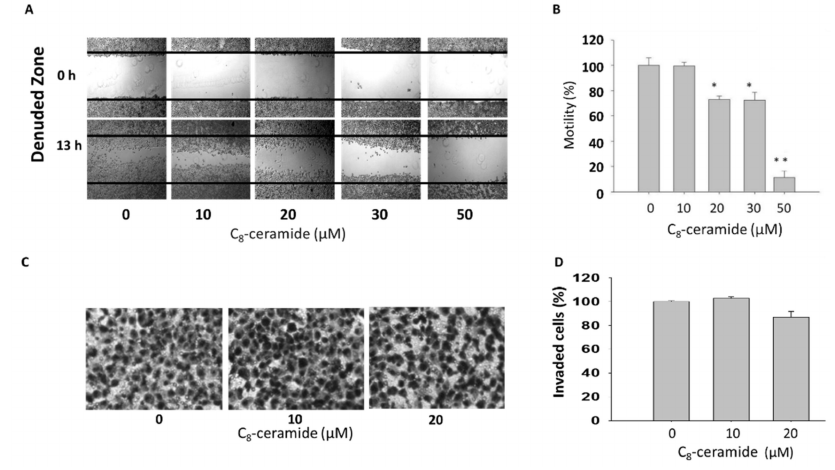
Figure 5. The effects of C8-ceramide on the migration and invasion of H1299 lung cancer cells. ( A ) A confluent culture of H1299 cells was seeded onto a 12-well plate, and cells have created a gap with a 200 µ L tip. The cells were treated with indicated concentrations (from 0 to 50 µ M) of C 8 -ceramide for 24 h respectively. ( B ) Quantitative analysis of ( A ) (* p < 0.05 and ** p < 0.001 for C 8 -ceramide treatment versus respective control). ( C ) Boyden’s transwell assay was conducted to examine the effect of C 8 -ceramide on the invasion of H1299 cells. ( D ) Quantitative analysis of ( C ) Magnification: 100 ×